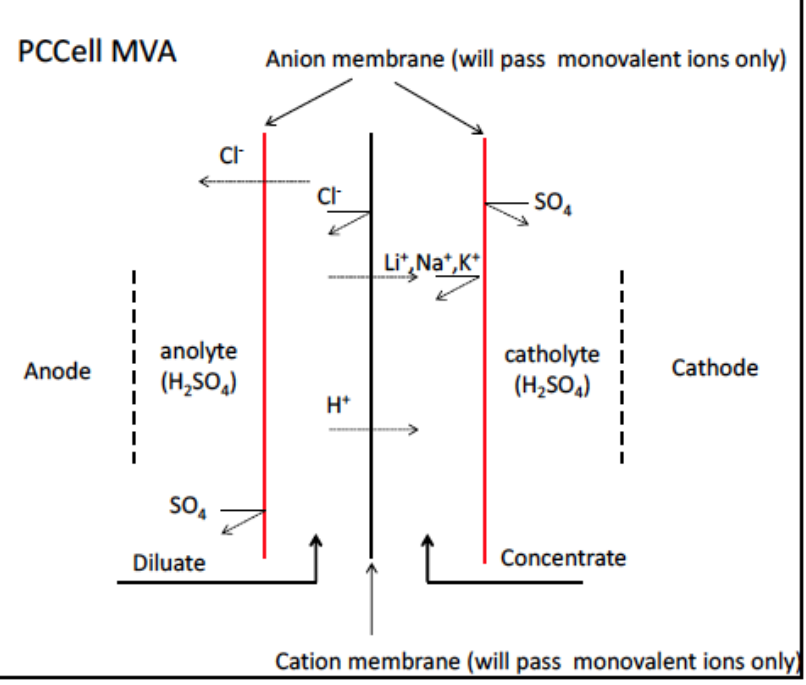
Figure 21. Schematic of an idealized electrodialysis (electrochemical) separation process [54].